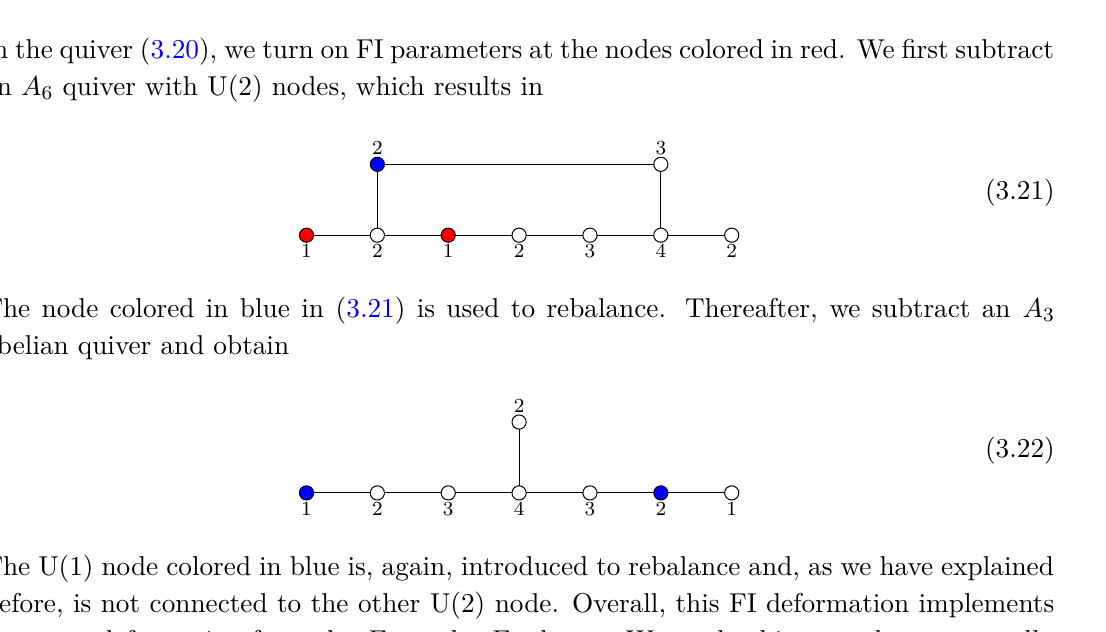
Figure 3. The FI deformation of the 6d magnetic quiver (3.2). We turn on FI parameters at the nodes in red, resulting in the second